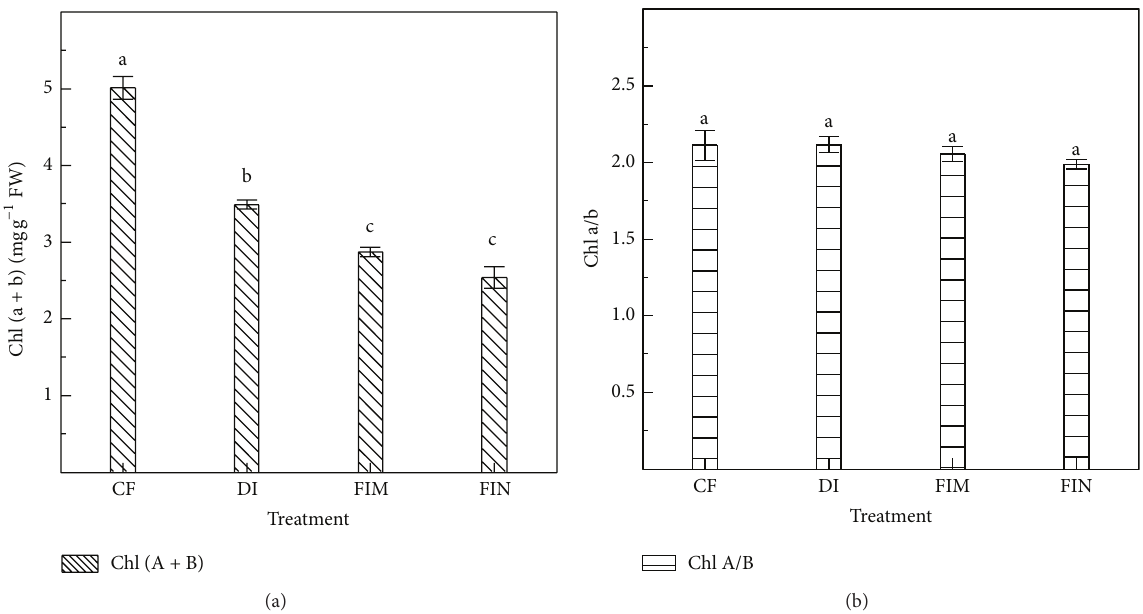
Figure 4: Chl content of cultivar Ninggeng28 ( Oryza sativa L.) under CF, DI, FIM, and FIN treatments at the grain-filling stage, respectively, in Shihezi. The CF indicates conventional flooding, and the DI, FIM, and FIN are plastic film mulching with drip irrigation, plastic film mulching with furrow irrigation, and no mulching with furrow irrigation, respectively. Vertical bars represent SE of the mean; the SE was calculated across five replicates for each year and averaged for the 2 years. Values of different treatments followed by the same letter indicate no significant differences ( 𝑃 < 0.05 ) according to least-significant-difference